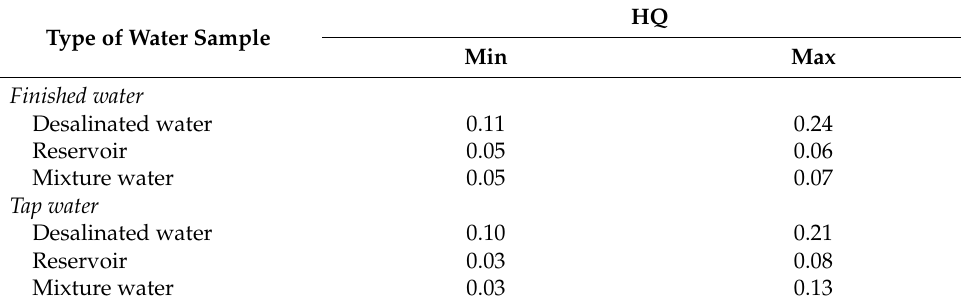
Table 5. Chronic non-carcinogenic risk of boron exposure in 2015–2016 (HQ).